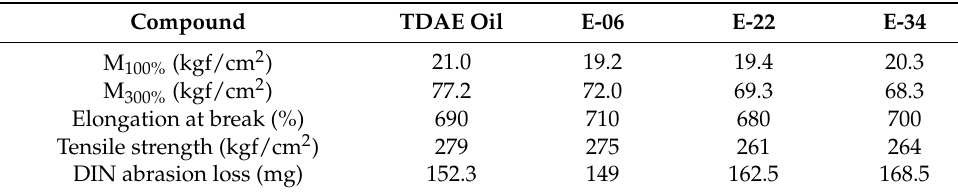
Table 7. Mechanical properties of the vulcanizates.